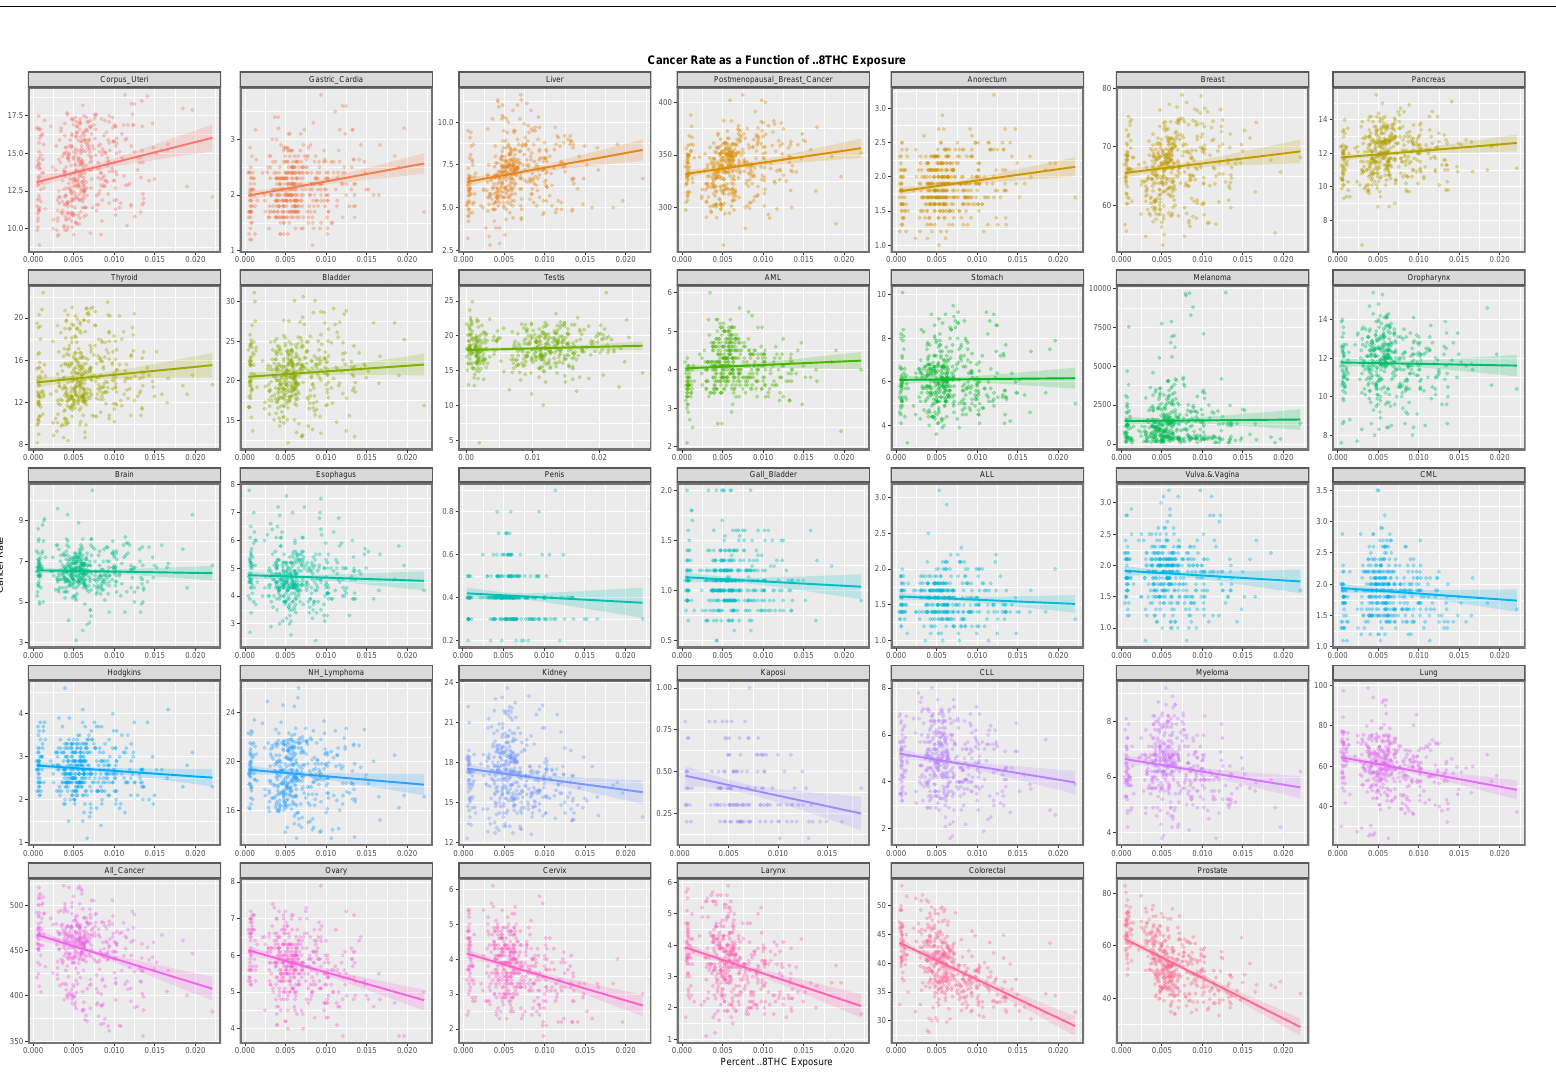
Figure 2. The bivariate continuous relationships of the ∆ 8THC rates by cancer